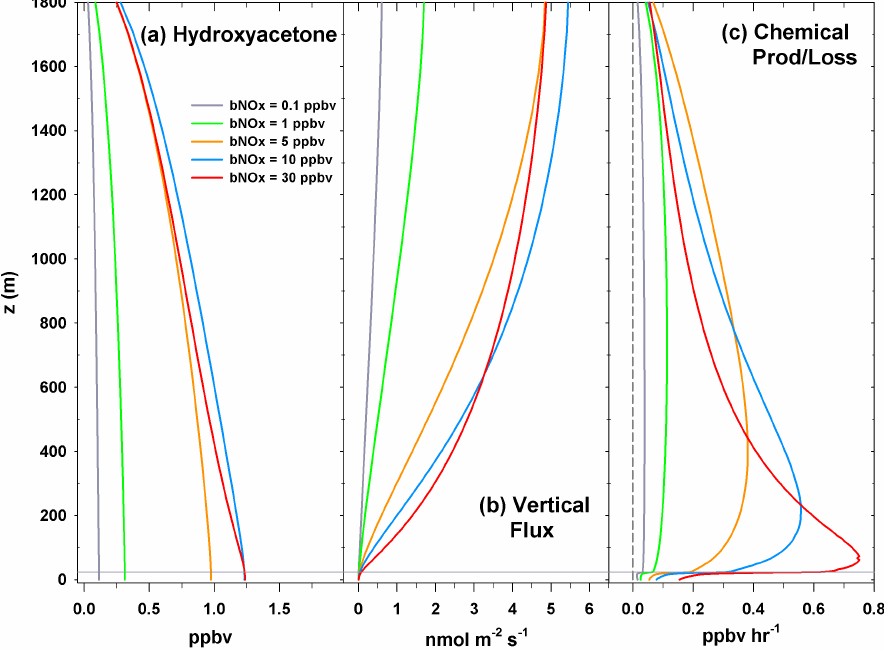
Fig. 14. Vertical profiles of hydroxyacetone (a) mixing ratio (ppbv), (b) vertical flux (nmolm − 2 s − 1 ) , and (c) chemical production or loss (ppbvh − 1 ) for each background NO x value (horizontal gray line is canopy top height). Table 2. Mean Within-Canopy Mixing Ratios (ppbv) for Selected Isoprene Oxidation Products as a Function of Background NO x and Simulated NO x . bNO x NO x methacrolein MVK glyoxal methyl glyoxal glycolaldehyde